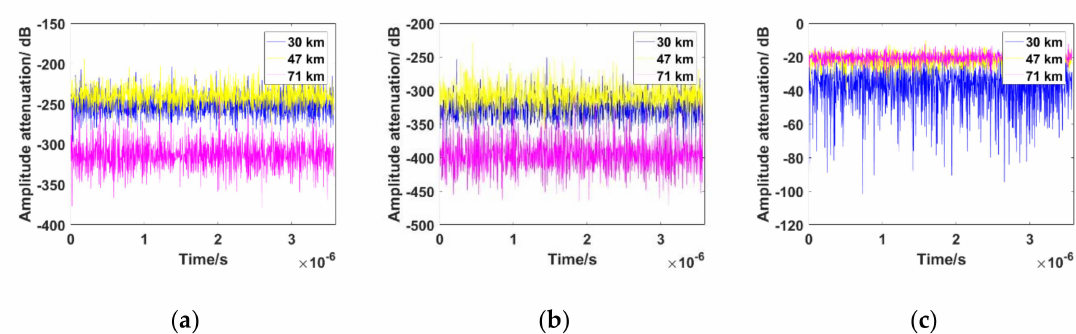
Figure 1. Amplitude attenuation of the received signal at different altitudes of RAM-C. ( a ) 2.3 GHz; ( b ) 5.8 GHz; ( c ) 30 GHz.